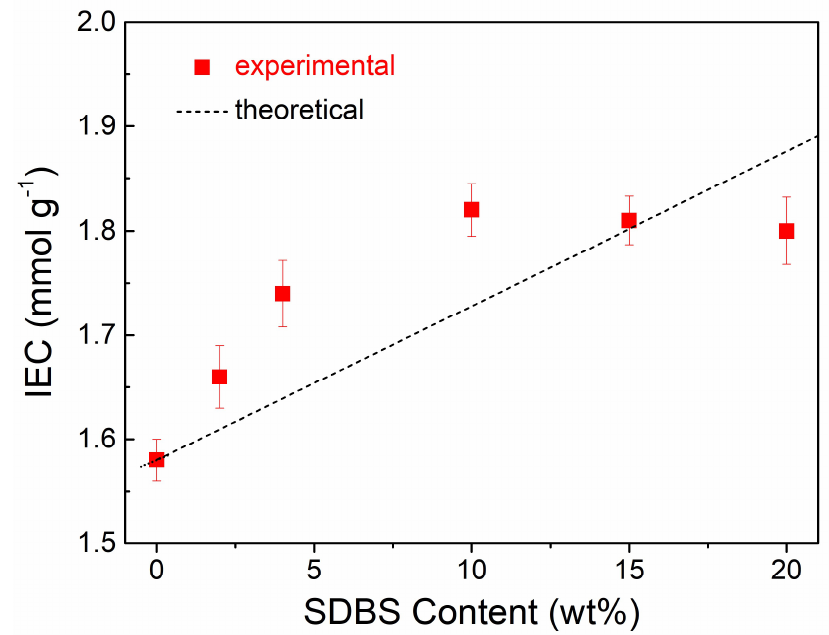
Figure 3. Ion exchange capacities (IECs) of SPEEK/SDBS membranes with various SDBS contents.